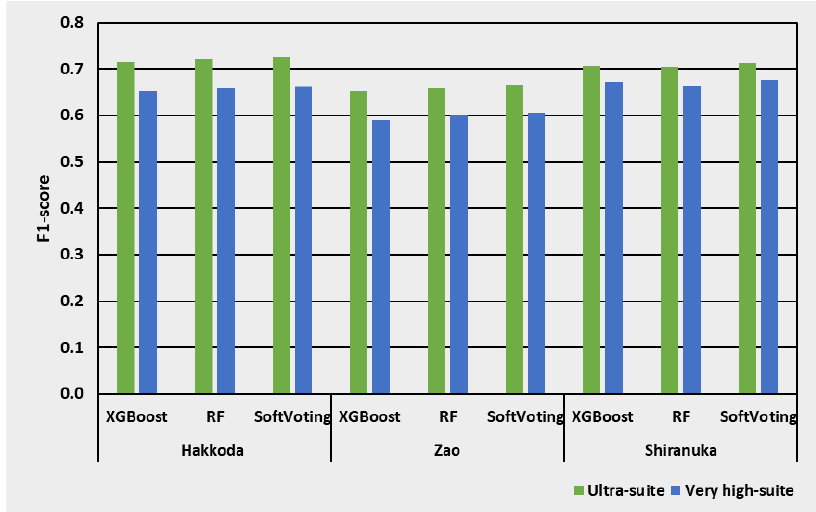
Figure 7. Accuracy variation with classifiers using single-date autumn images.